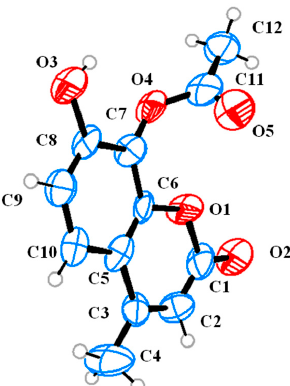
Figure 4. ORTEP diagram showing crystallographic atom numbering and solid-state conformation for 8-acetoxy-7-hydroxy-4-methylcoumarin ( 3a ; CCDC-1508122). Crystallographic data have been deposited with Cambridge Crystallographic Data.